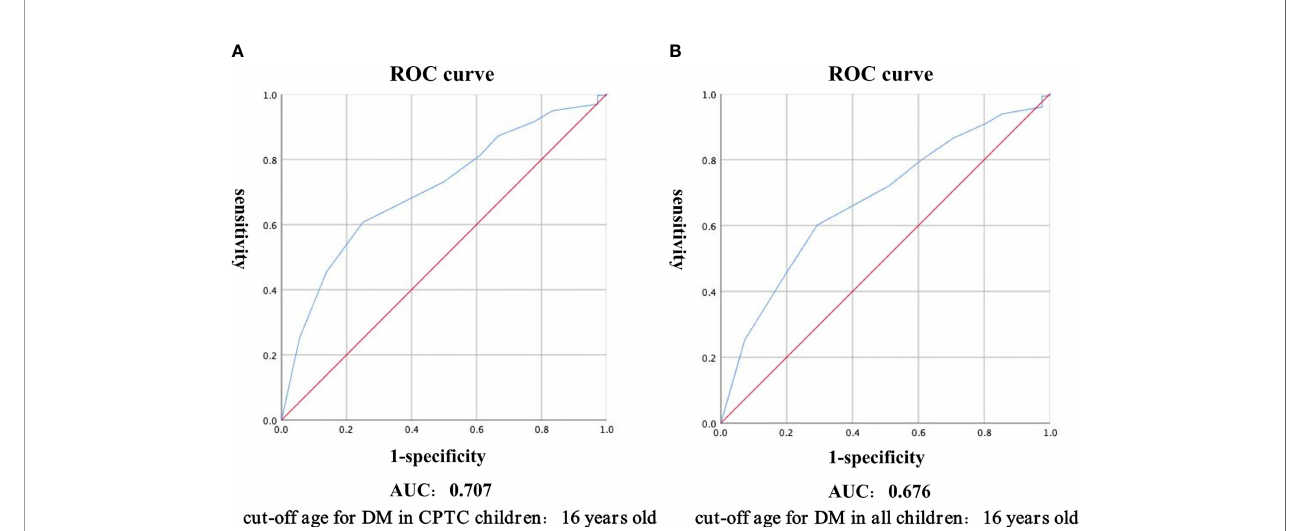
FIGURE 1 | Receiver Operating Characteristic curve was used to calculate the cut-off age for distant metastasis in CPTC children (A) , and all children (B) . ROC, receiver operating characteristic; CPTC, classical papillary thyroid carcinoma; AUC, area under